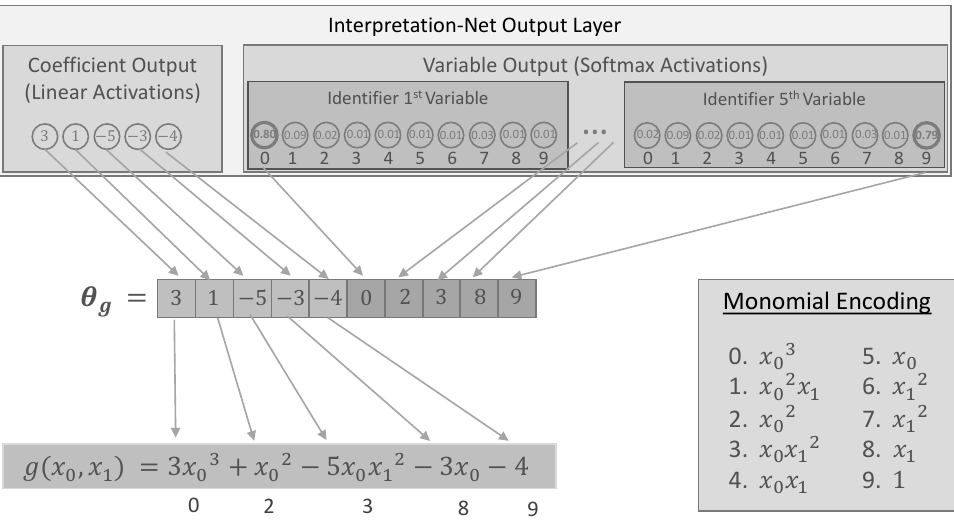
Figure 3. I -Net output layer. The sparse polynomial representation is predicted by the I -Net using different output layers and